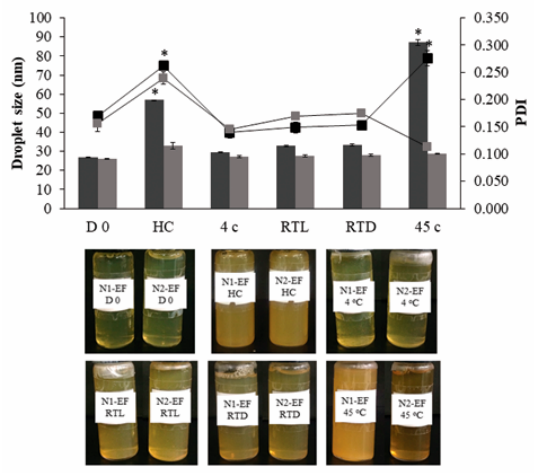
−− Figure 4. Mean zeta potential of N1 - EF (  ) and N2 - EF (  ) at the starting point ( D 0 ) and after storage in various conditions including HC—heating - cooling for six cycles, 4 °C, room temperature with light ( RTL ) , room temperature without light ( RTD ) , and 45 °C for 90 d ( mean ± SD; n = 3 ) , * indicates a significant difference ( p < 0 . 05 ) from D 0 of each formulation . Figure 4. Mean zeta potential of N1- EF ( (cid:4) ) and N2-EF ( (cid:4) ) at the starting point (D 0) and after storage in various conditions including HC—heating-cooling for six cycles, 4 ◦ C, room temperature with light (RTL), room temperature without light (RTD), and 45 ◦ C for 90 d (mean ± SD; n = 3), * indicates a significant di ff erence ( p < 0.05) from D 0 of each